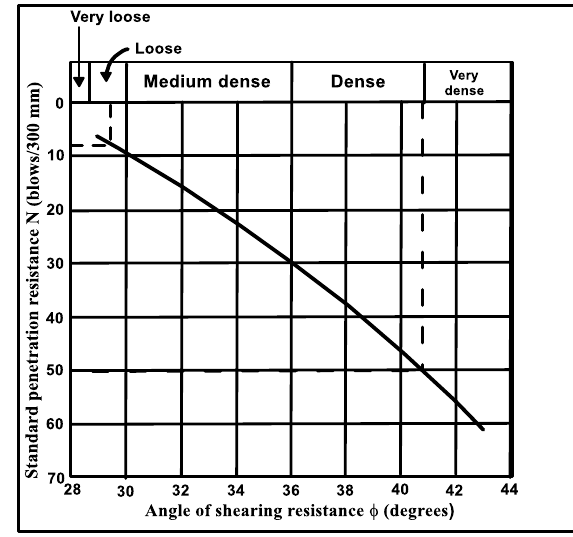
Figure 6: Relationship between SPT Values and Angle of Figure 7: Relationship between SPT Values and Angle of Shearing Resistance (Peck et al., 1967)